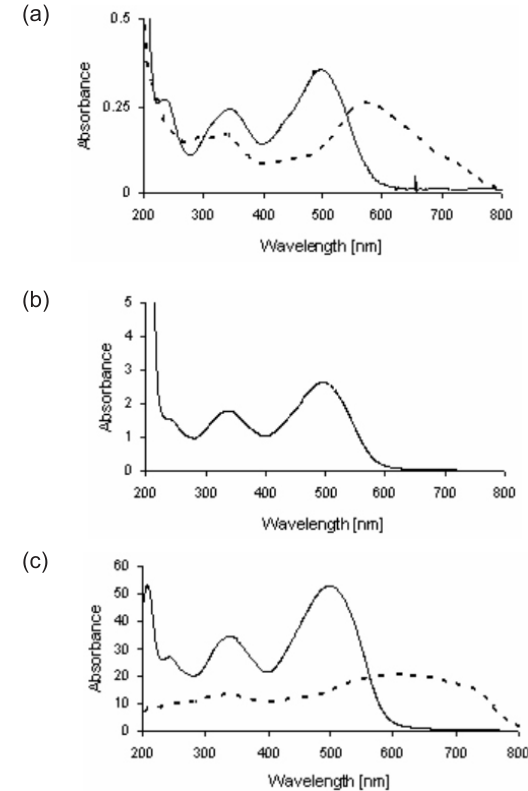
Figure 2. UV/VIS spectra: (a) free Congo red in water ( ____ ) and aqueous 0.1 M HCl solution ( - - - ); (b) the silica gel functionalized with Congo red; (c) the silica gel functionalized with Congo red treated with water ( ____ ) and aqueous 0.1 M HCl solution ( - - -